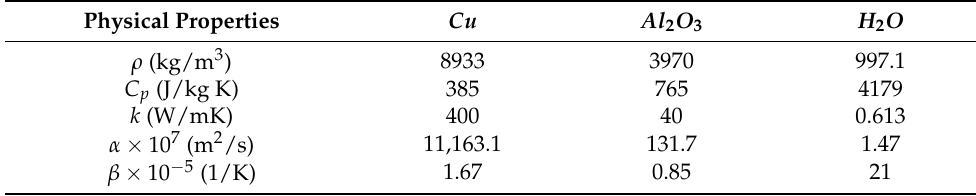
Figure 1. Physical configuration and coordinate system. Table 1. Thermophysical properties of nanoparticles and water